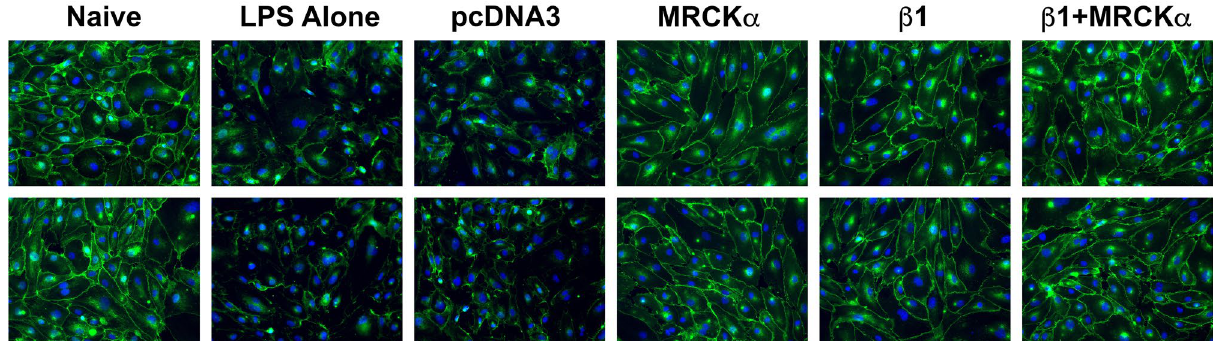
Figure 4. Overexpression of MRCKα or the Na + ,K + -ATPase β1 subunit in microvascular endothelial cells attenuates LPS-induced reduction of VE-cadherin expression. Human MVECs grown on coverslips were transfected with plasmids (2 µg/well) expressing either no insert (pcDNA3), MRCKα, the β1 subunit of the Na + ,K + -ATPase (β1), or β1 and MRCKα. Forty-eight hours later, cells were treated with nothing (Naïve) or LPS (1 µg/ml) for 5 h prior to fixation and immunofluorescent staining for VE-cadherin. The experiment was carried out on triplicate coverslips in three different experiments and representative images from two different wells are shown.